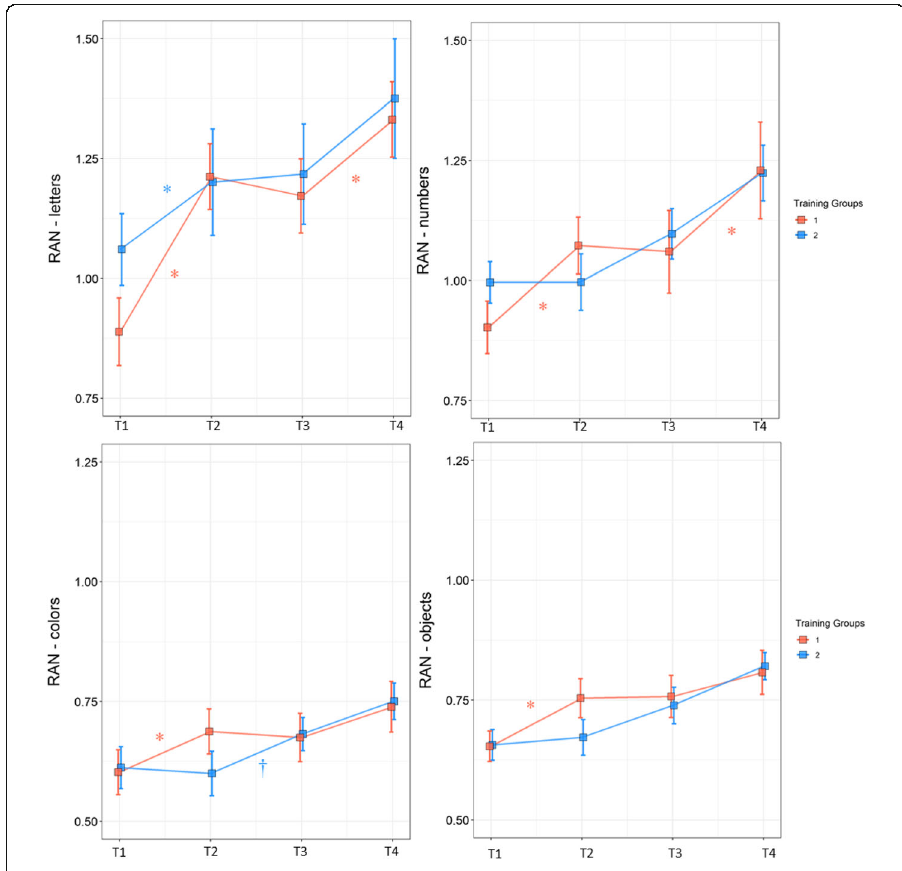
Fig. 2 Group means in each time point for RAN subtasks. Error bars represent SEM. Data from group 1 are shown in red and data from group 2 in blue. Effects of the t tests between each pair of time points are indicated by asterisks ( p corr < 0.05) and daggers ( p corr <